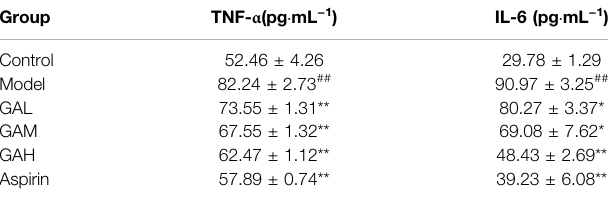
TABLE1 | Effects of different doses of gallic acid on the levels of TNF- α and IL-6 (mean ± SD).